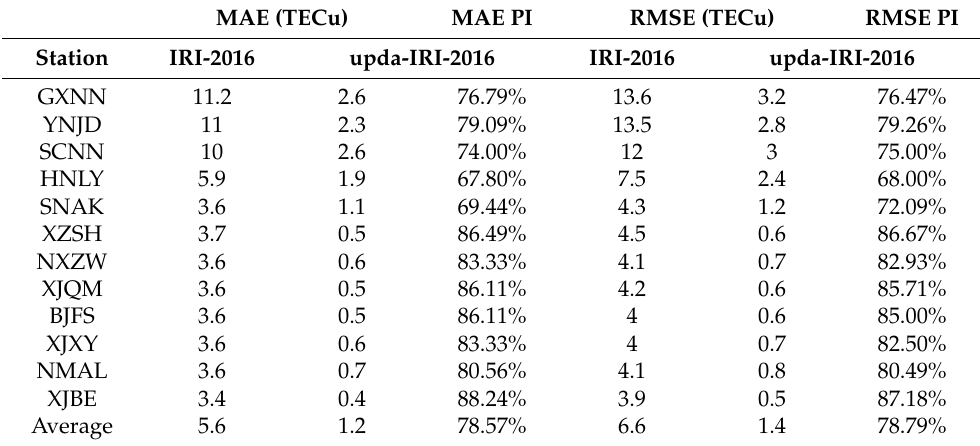
Table 3. Statistical results for the MAEs, RMSEs, and PIs of the TEC estimates for 2015.